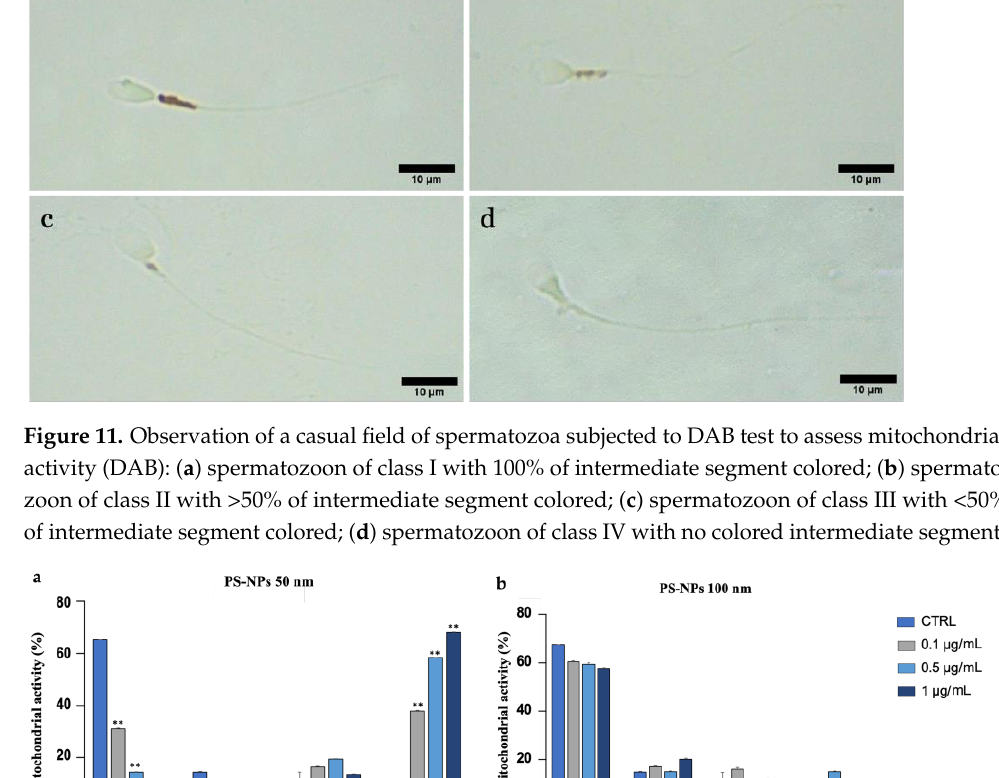
Figure 10. Correlation analysis: ( a ) relation between HSP70 expression and DNA fragmentation; ( b ) relation between HSP70 expression and oxidative stress; ( c ) relation between HSP70 expression and mitochondrial disfunction.